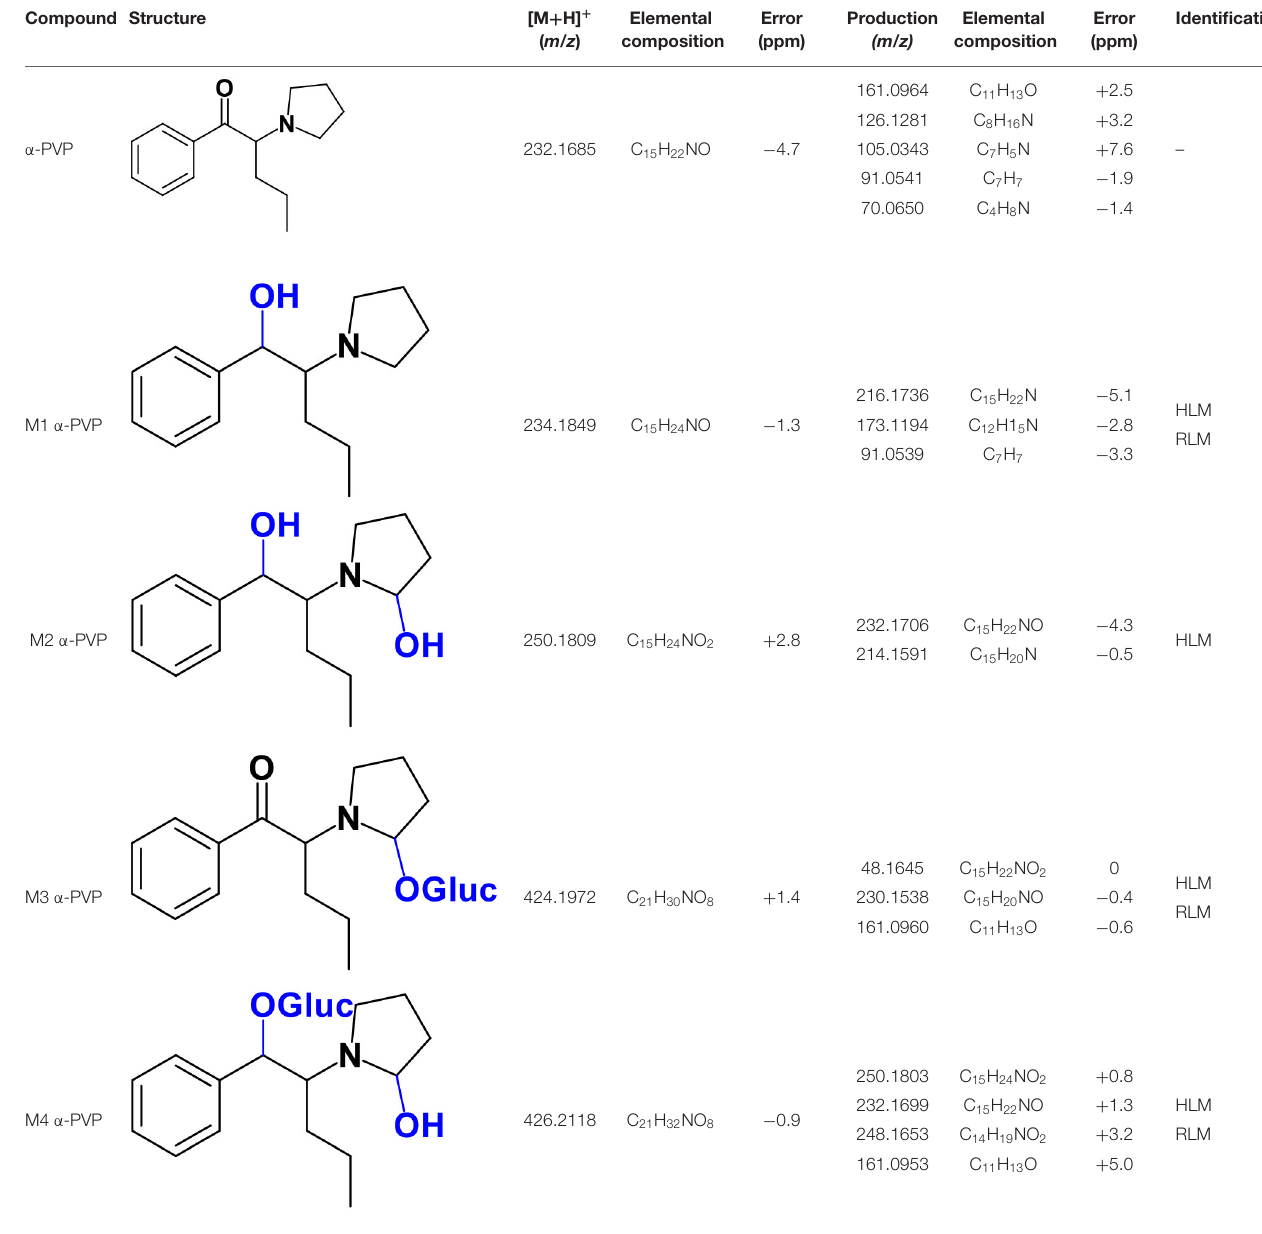
TABLE 1 | Structures of the α -PVP metabolites identified in HLM and RLM incubations by LC-HRMS/MS (ESI + ) analysis. Compound